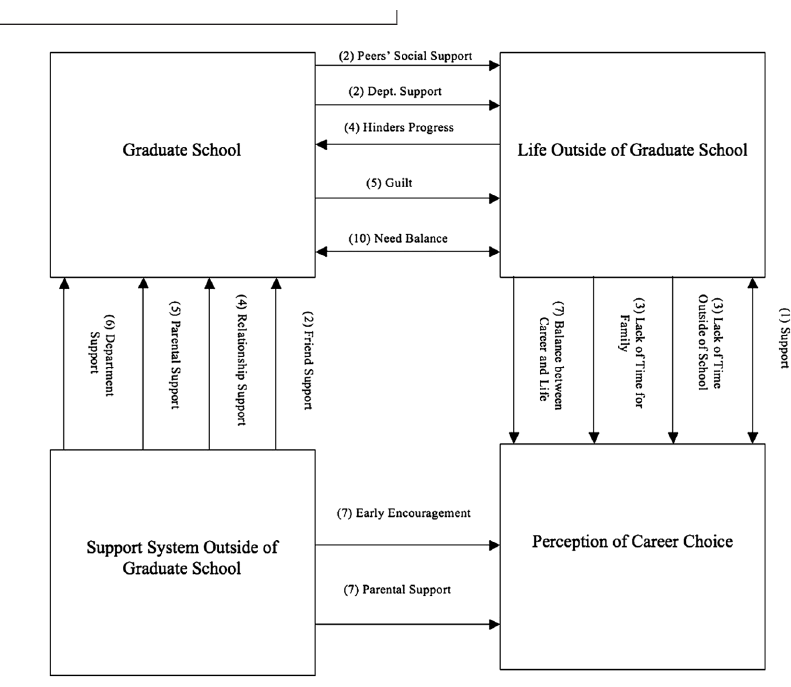
FIG. 5. Final model.